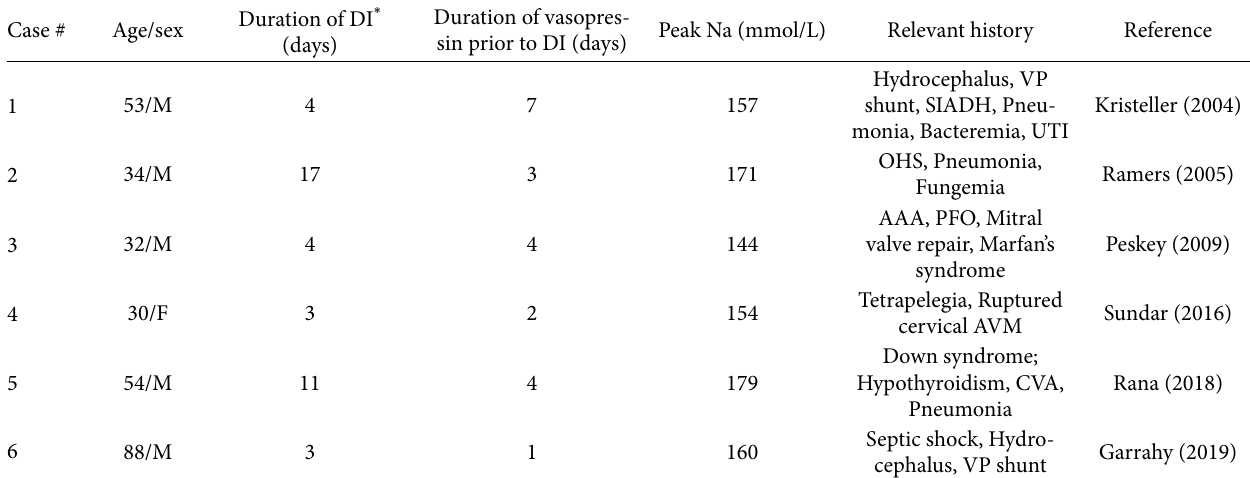
Table 1: Characteristics of reported cases of diabetes insipidus after vasopressin withdrawal. ∗ Defined by rise of urine volume correlating with spike in Na through normalization of the